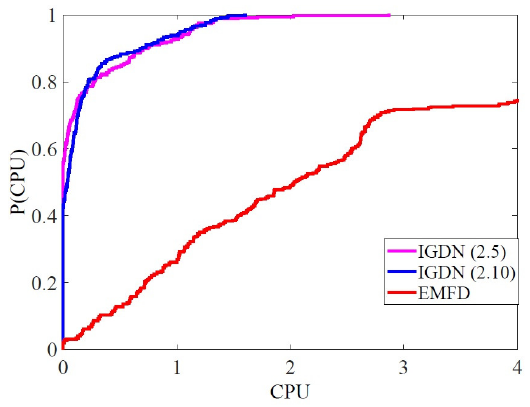
Figure 3. Performance profile of IGDN versus EMFD [8] with respect to CPU